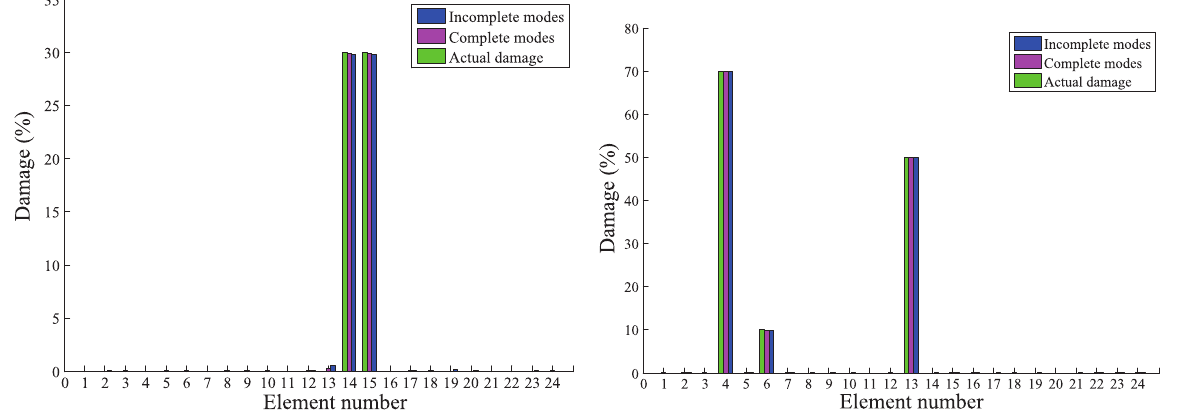
Fig. 11. Damage detection via BB-BC for two damage locations of frame (Scenario 1).